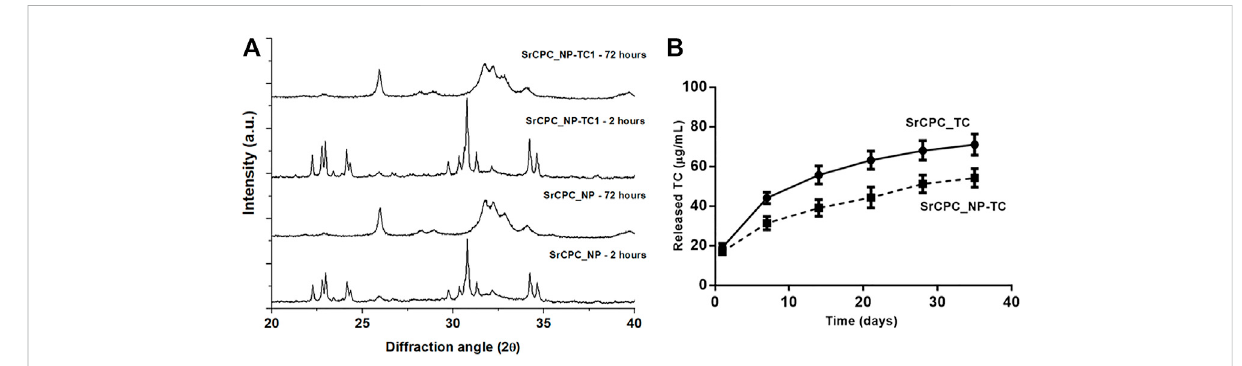
FIGURE 4 (A) XRDofcementswithTC(SrCPC_NP-TC1) andwithoutTC(SrCPC_NP)at2and72 huponmixingandmaturationat37 ° C; (B) Release pro fi le of TC from cements with NPs (SrCPC_NP-TC) and without NPs